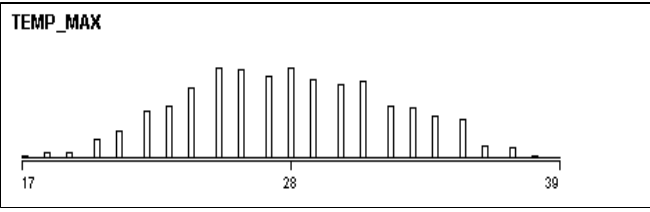
Figure 1: Maximum Temperature (ºC) and fails per month (2017).